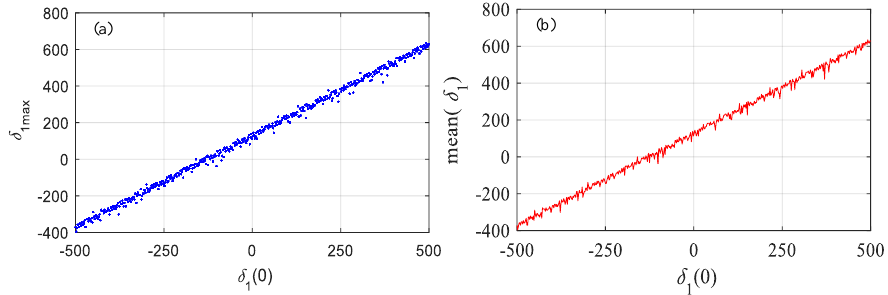
Figure 3. ( a ) Bifurcation diagram of the system with the variation of δ 1 ( t 0 ) and ( b ) the mean value of δ 1 .